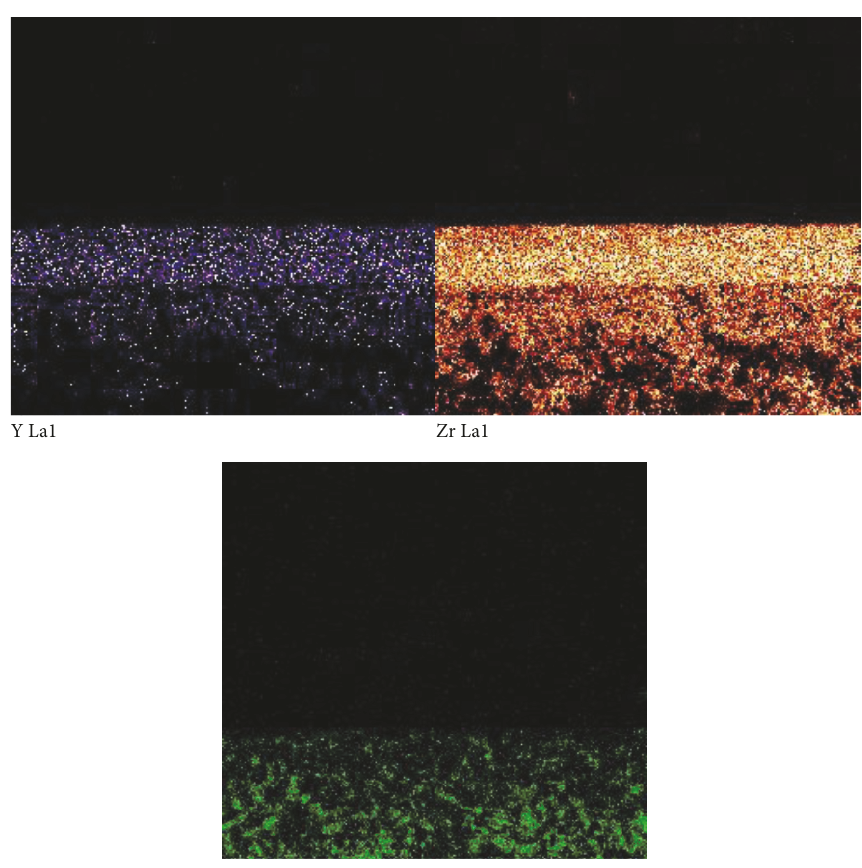
Figure 5: EDS chemical maps for Y, Zr, and Ni